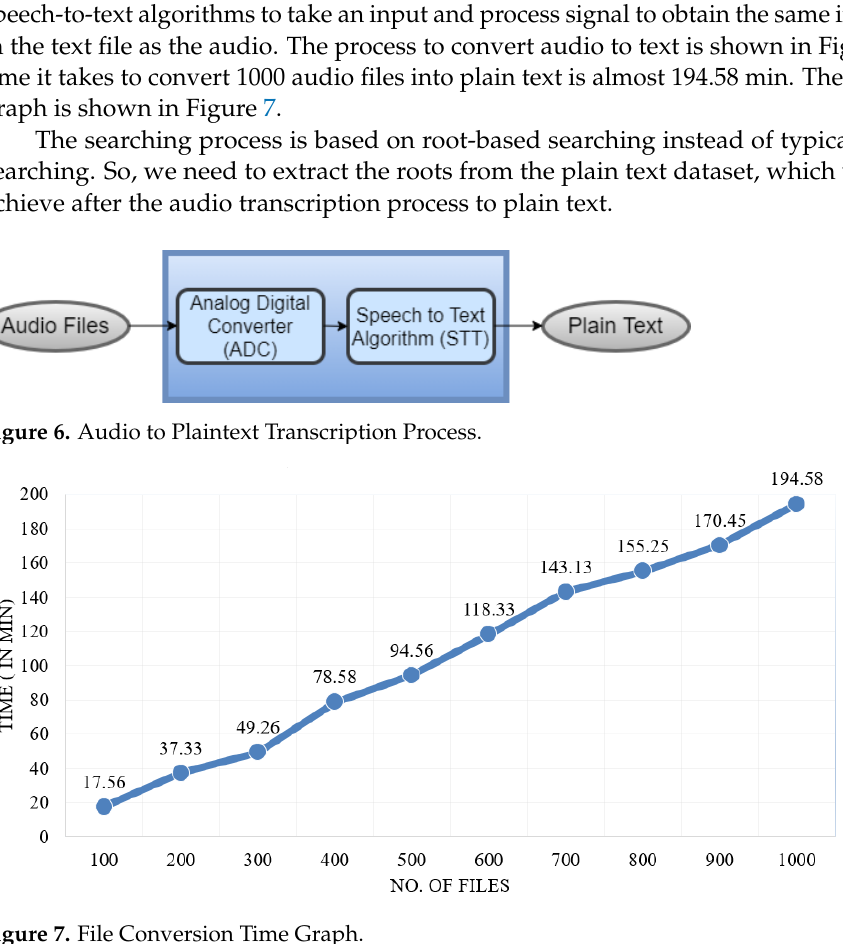
Figure 7. File Conversion Time